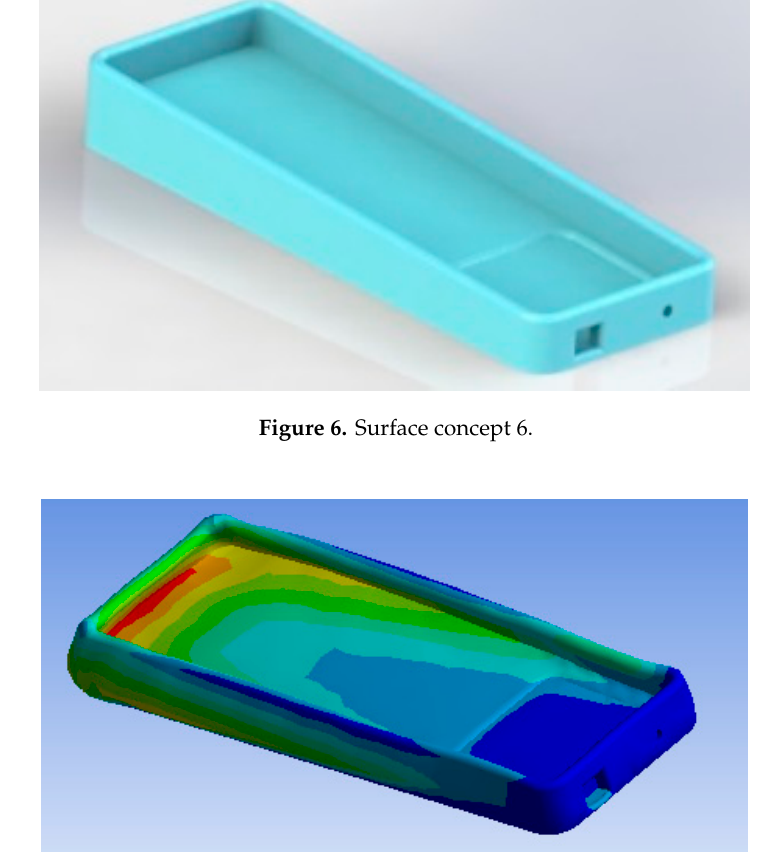
Figure 6. Surface concept 6.